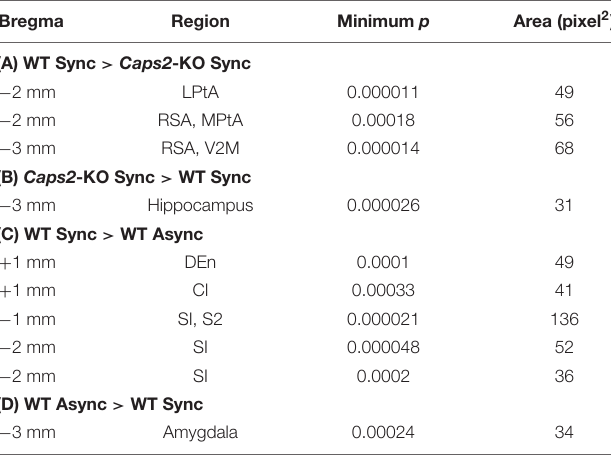
TABLE 1 | Regions that have significant difference in c-Fos imaging among groups. Bregma Region Minimum p Area (pixel 2